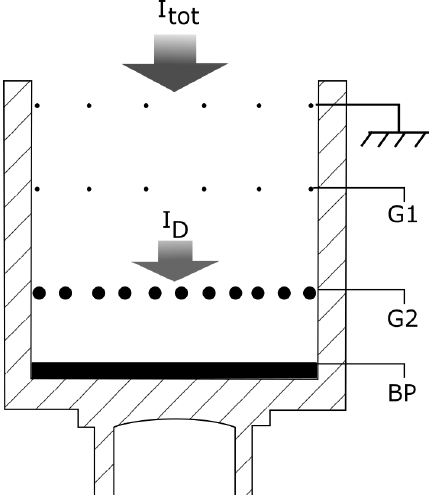
Figure 1. Cross section of the DUSTY probe. The upper grid is pay- load ground intended to shield neighbouring probes from E-fields. The grids G1 and G2 and the bottom plate (BP) have potentials optimized to shield ambient plasma and detect mesospheric dust and ice particles. The wire thickness is exaggerated there for conve- nience, and we also note that the G2 wires are thicker than the G1 and shielding grid